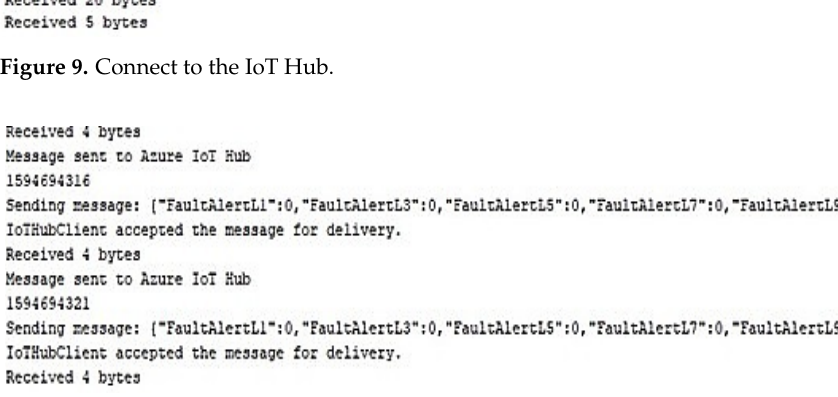
Figure 10. Sending input data to the IoT Hub.